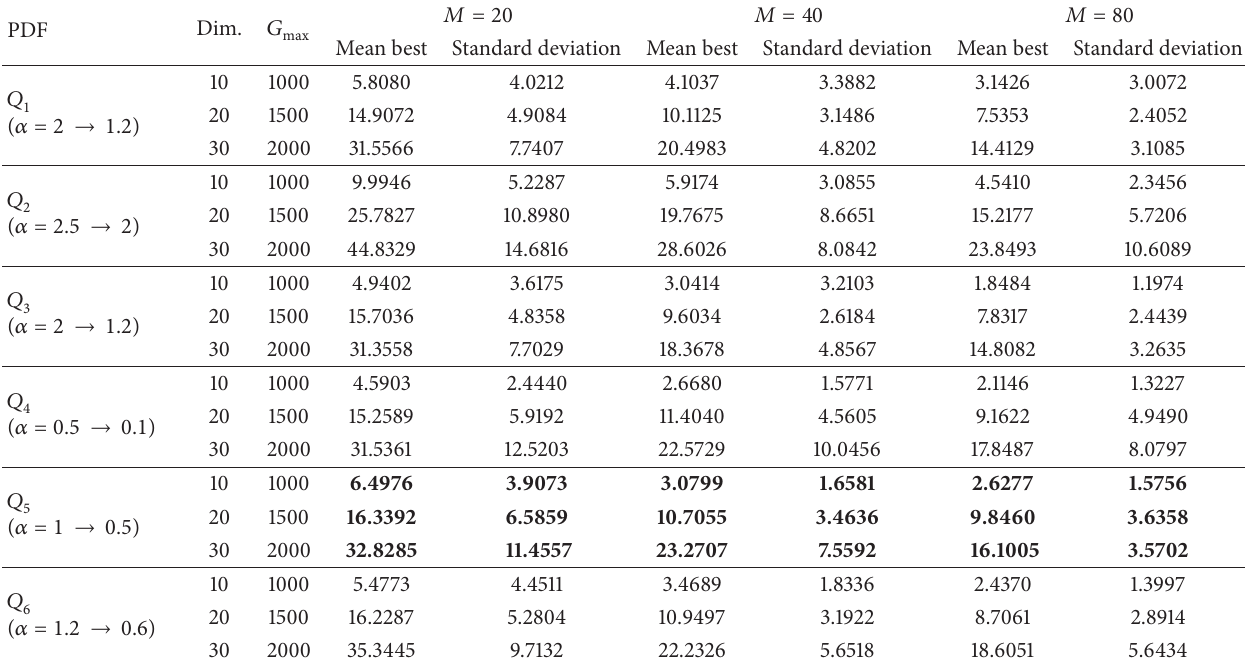
Table 4: Mean best fitness values and standard deviation for the generalized Rastrigrin function. PDF